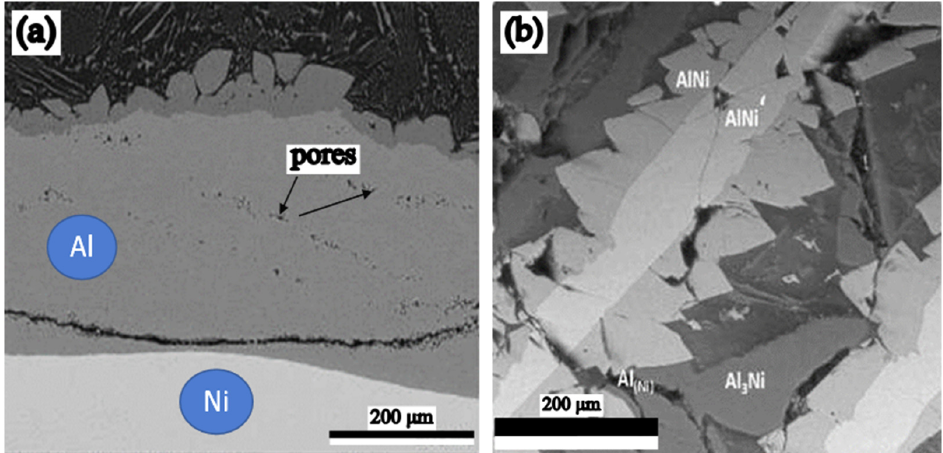
Figure 2. The diffusion porosity generated by the Kirkendall–Frenkel effect in the Al-Ni diffusion couple after holding for 50 h at 650 °C ( a ) [35], and the presence of Al 3 Ni aluminide highlighted in the SEM image performed in the Al matrix after holding at 1000 °C for 20 h, in contact with the Ni matrix ( b ) [36].